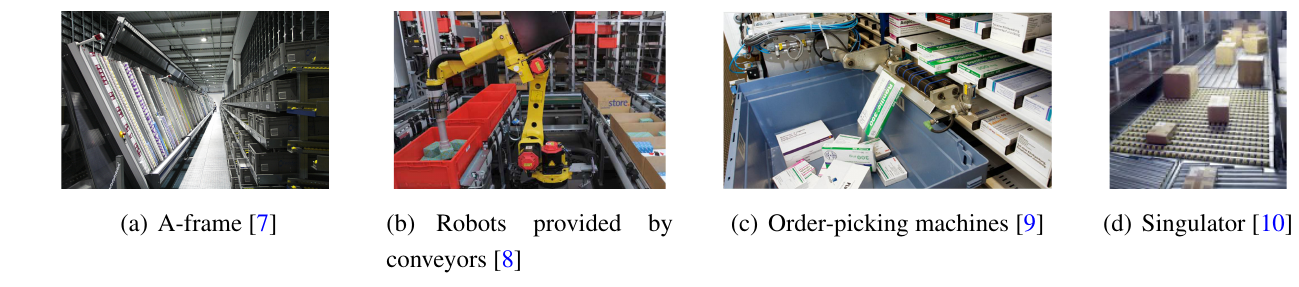
Figure 1. Different solutions of automated